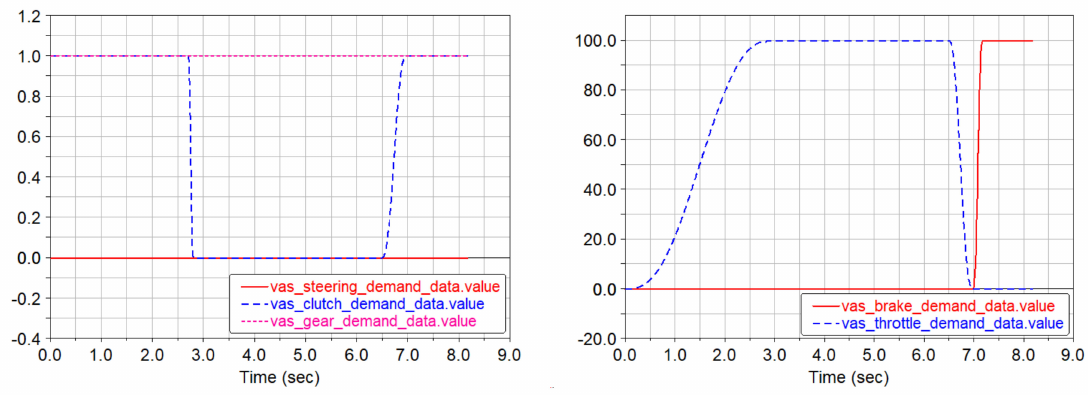
Figure 9. Brake Test-Driver